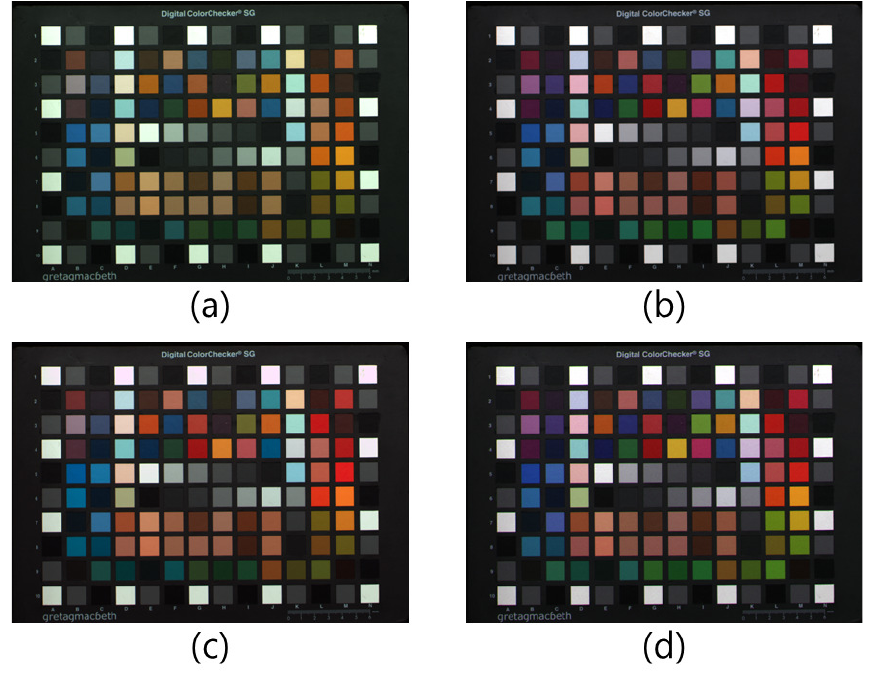
Figure 9. Experimental results (fluorescent lamp): ( a ) RWB image before RGB color conversion; ( b ) RGB color image; ( c ) 3 × 3 color correction matrix (CCM); and ( d ) Proposed